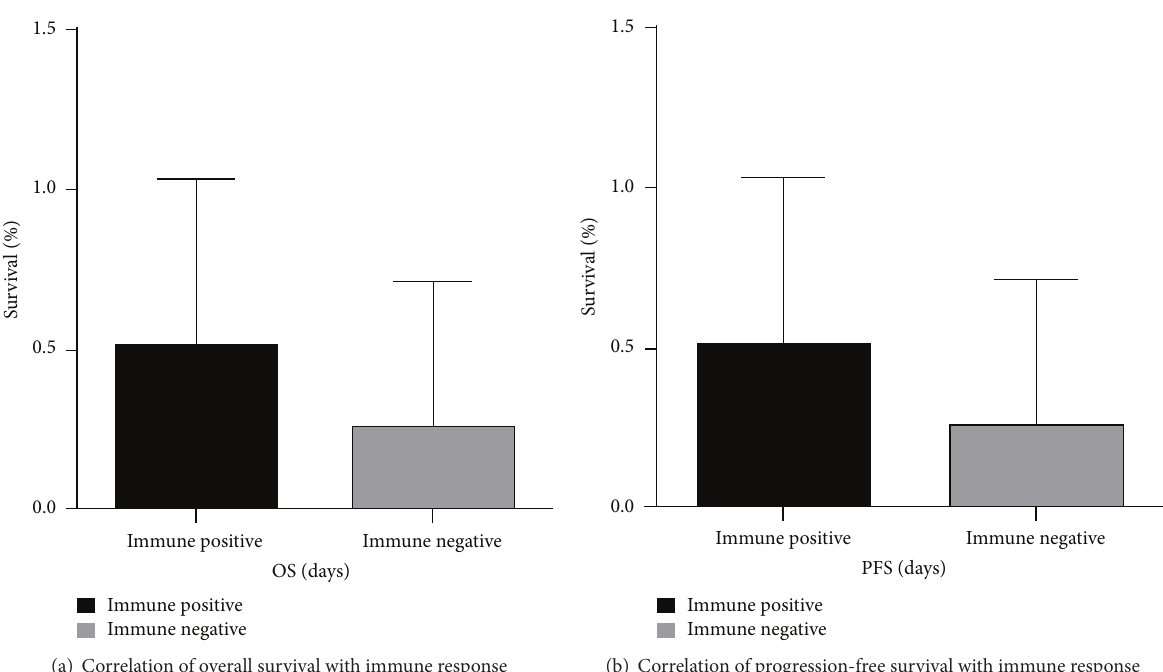
Figure 2: The eighteen patients who received neoadjuvant radiation and DC vaccine were divided into two groups based on their immune response (positive and negative) and then correlated with the overall survival in days and progression free survival.